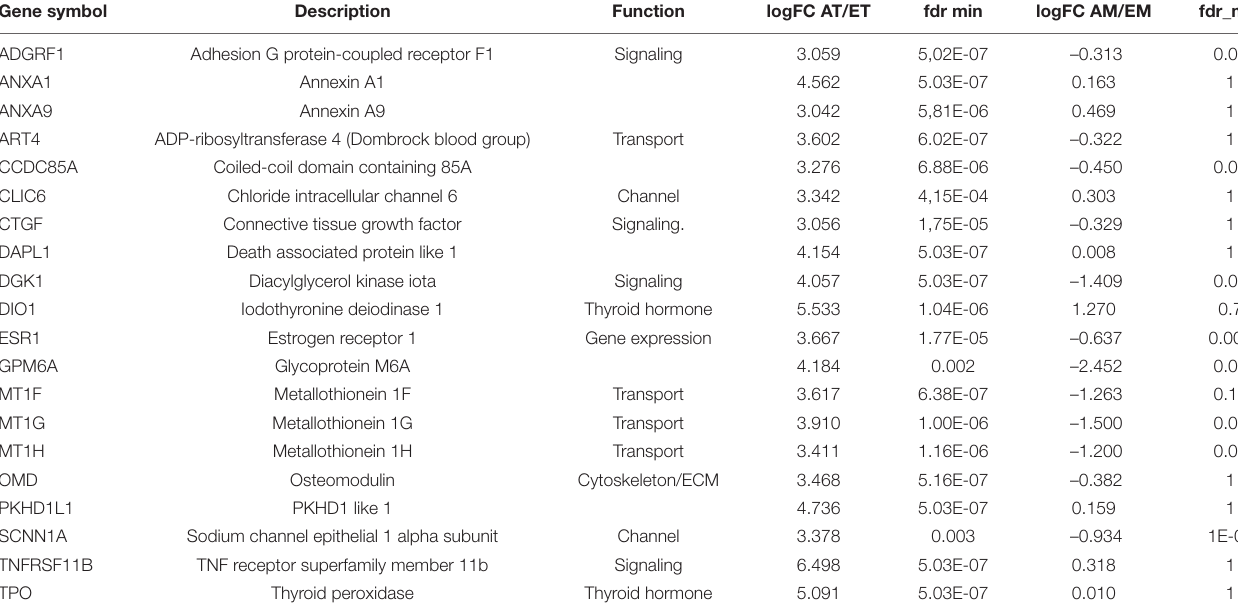
TABLE 2 | Top 20 genes differentially regulated in the course of thyroid development as compared to the development of non-thyroid tissues. Gene